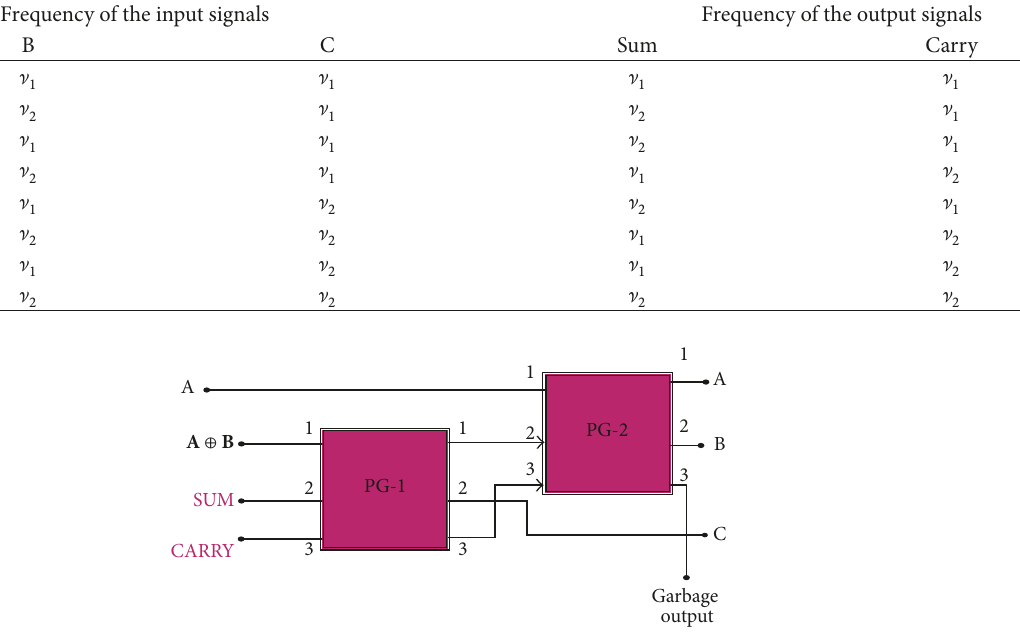
Figure 11: Scheme of data recovery circuit of the proposed full adder using Peres gates.